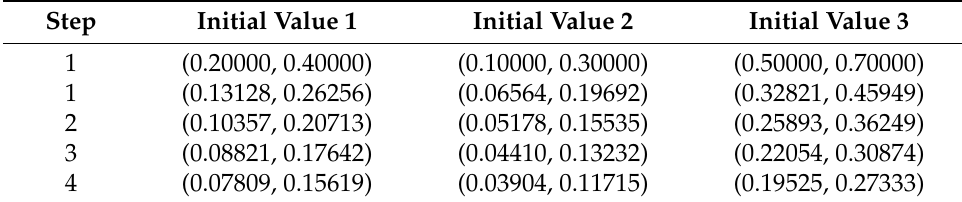
Table 1. Convergence of (5) for various initial values.